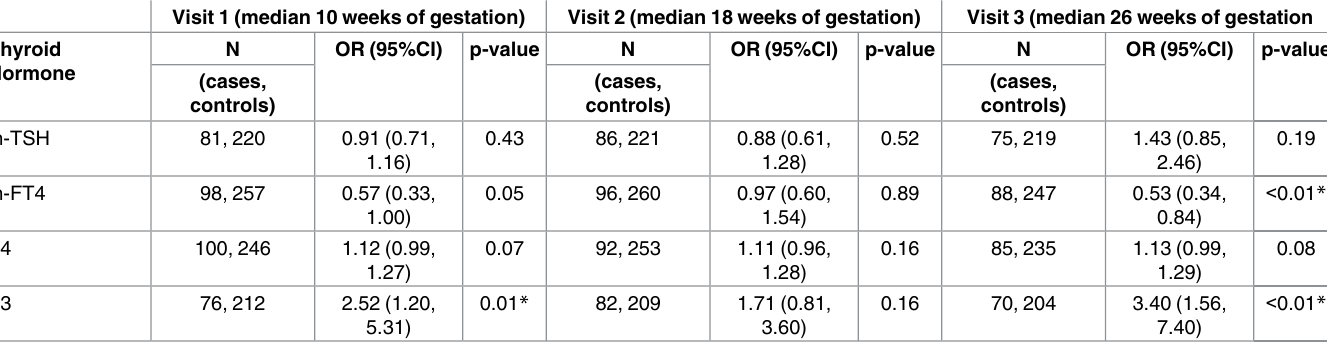
Table 3. Adjusted odds ratios (95% CI) of overall preterm birth (N = 116 cases)associated with a unit increasein thyroid hormone parameters. Visit 1 (median 10 weeks of